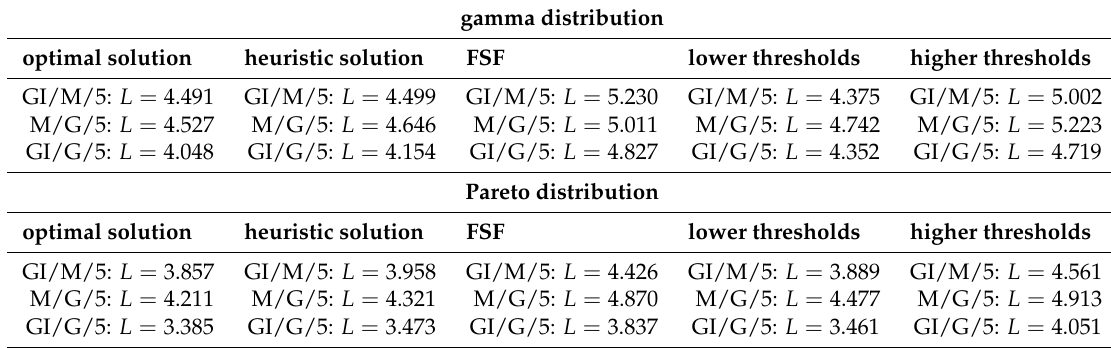
Table 6. Simulation results for the GI / M /5, M / G /5 and GI / G /5 queueing